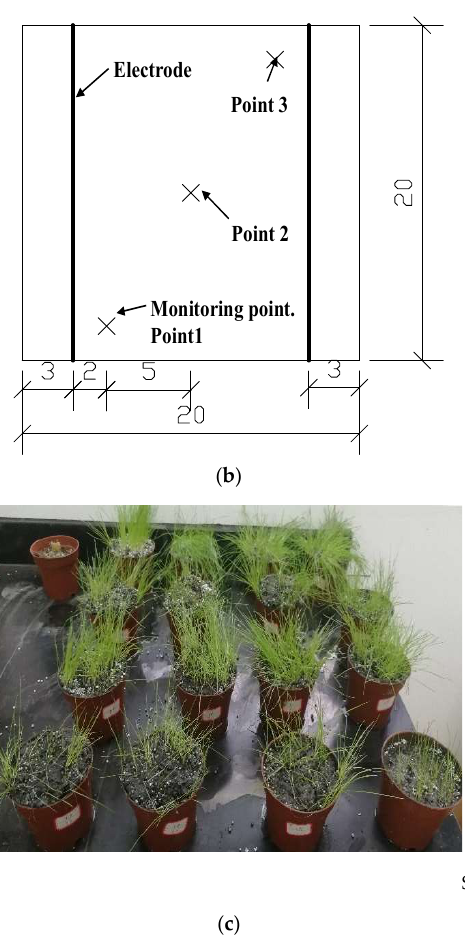
Figure 3. Field measurement to temperature of substrate; ( a ) test mold and instruments of field test; ( b ) detailed distribution of measurement points (unit: cm); ( c ) the plants that have been grown in the developed